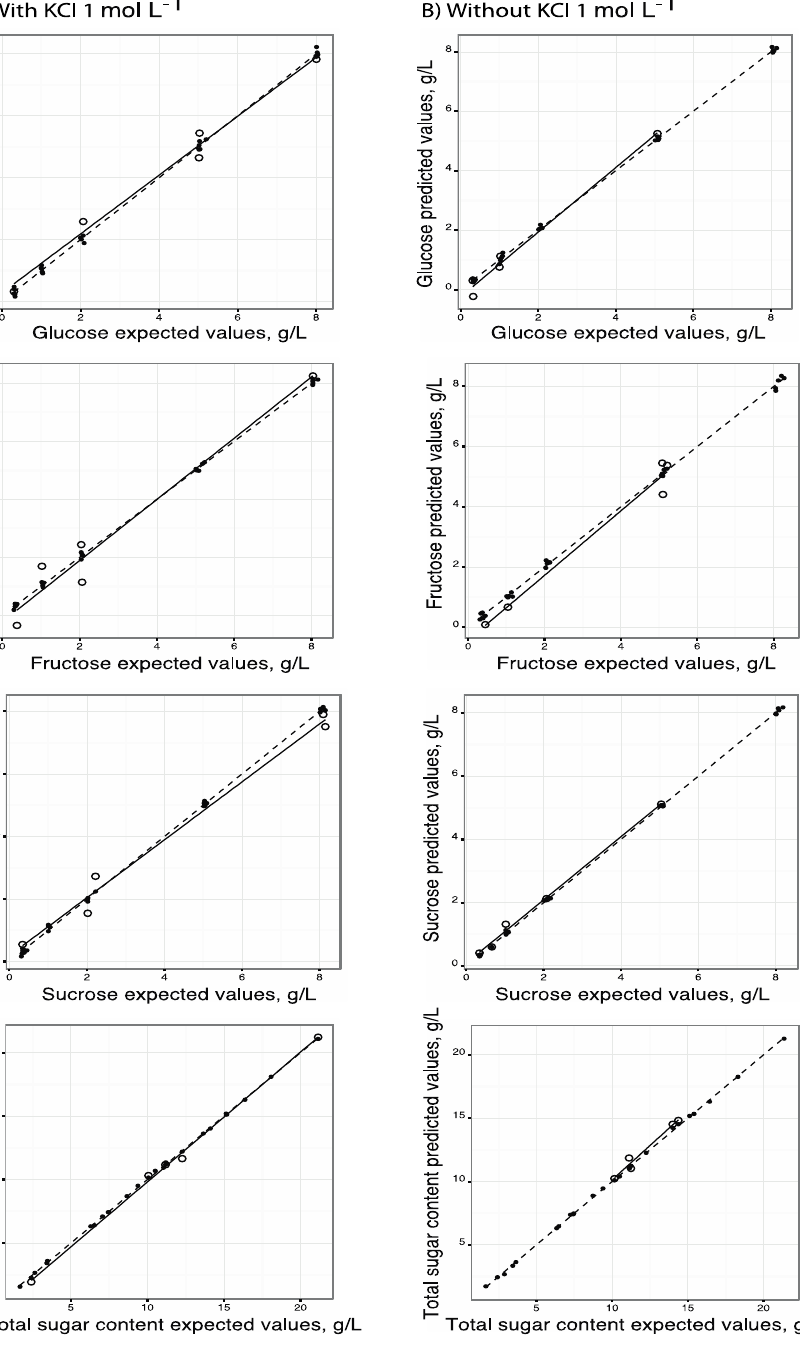
Figure 5. Linear relations between the predicted concentrations of sugars (glucose, fructose and sucrose) and total sugar content by the MLR models, using the sensors selected by the simulated annealing algorithm, and expected concentrations for the training (dotted line and solid marker) and test data (solid line and circle marker): ( A ) Standard solutions with KCl 1 mol L − 1 ; ( B ) standard solutions without KCl 1 mol L − 1 .